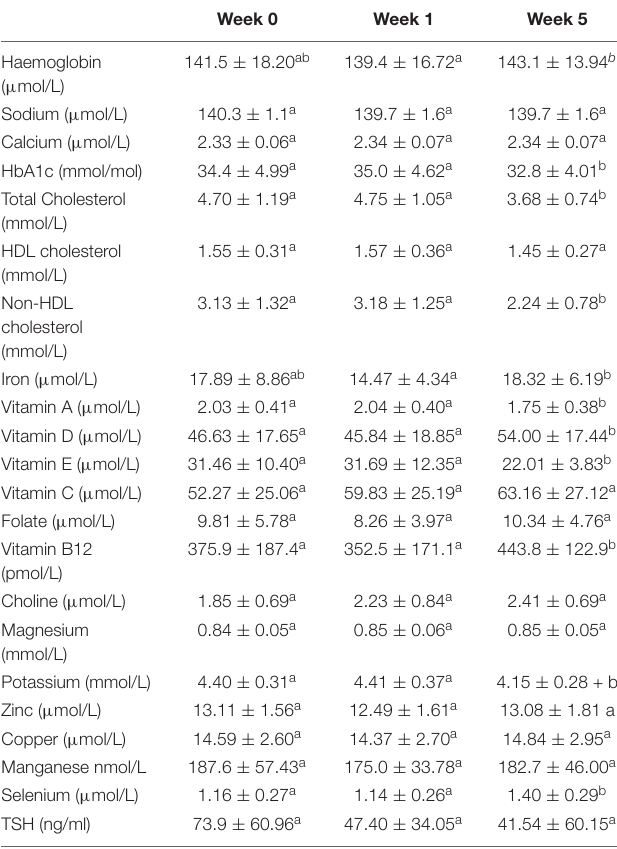
TABLE 2 | Statistical changes in micronutrients comparing weeks, 0, 1 and 5.